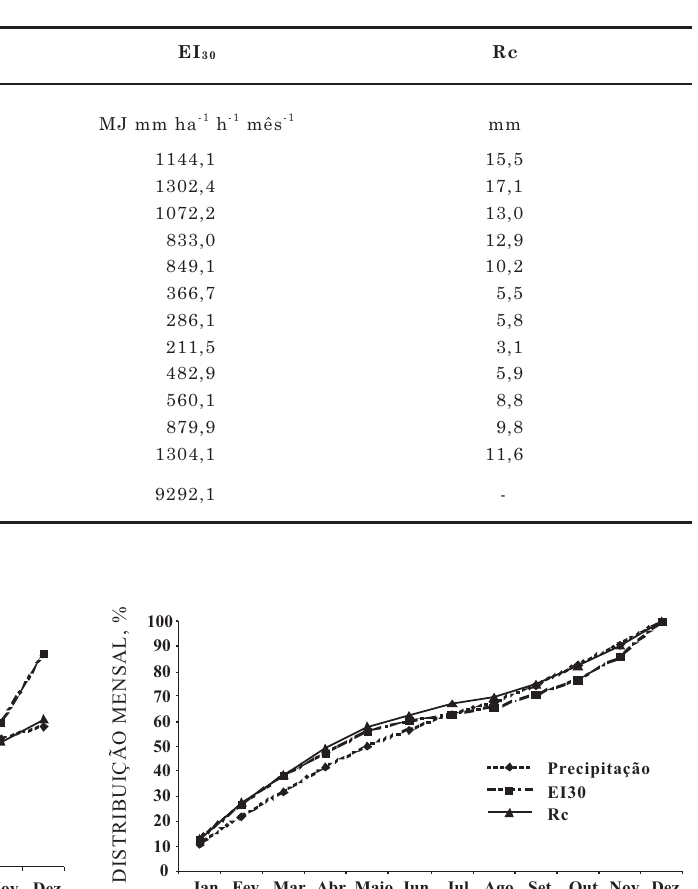
e coeficiente 30